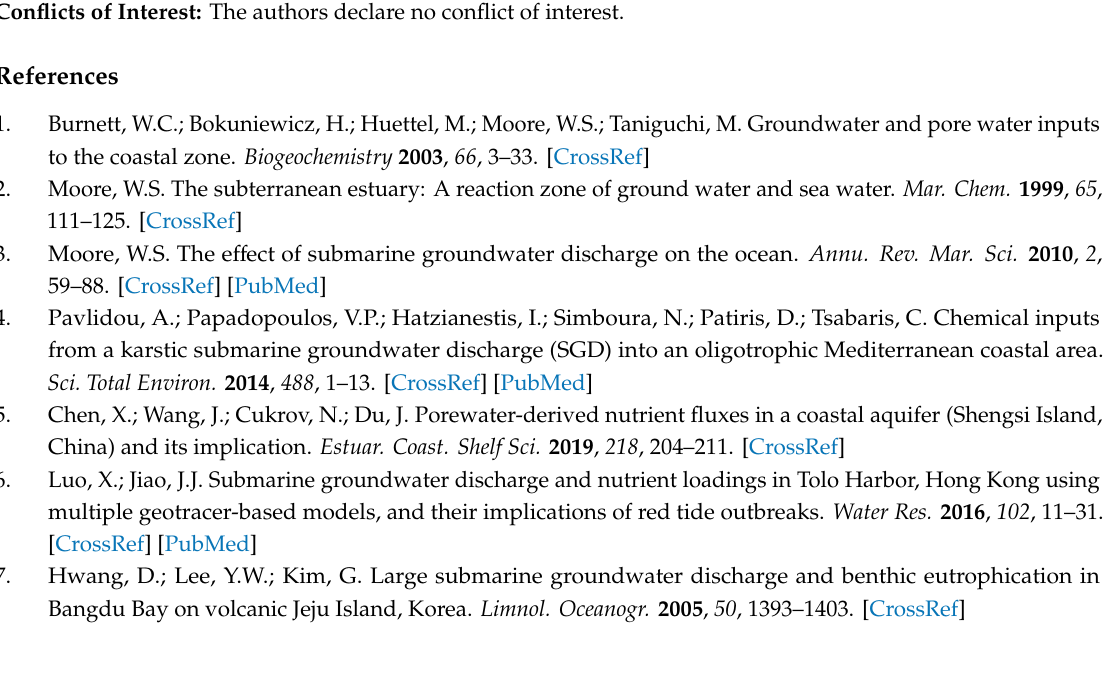
Table S1: DNA results for each